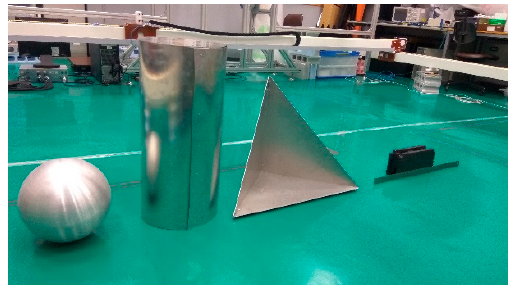
Figure 9. Targets available for experiments. The cylinder is not part of this report. During the measurement, the bar can be positioned horizontally or vertically.